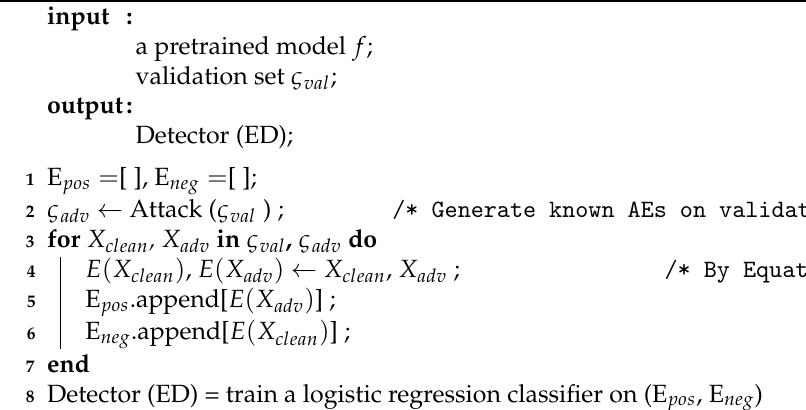
Figure 3. Framework of energy-based detection on a pretrained model. The above energy map is generated by clean samples and their CW adversarial examples with the R3 constraint on the ResNet34 network. The two blue dashed lines are positioned at the mean energy values of the clean samples and AEs, respectively. More visualizations can be found in Section 4.7. Algorithm 1: Energy-based adversarial detector